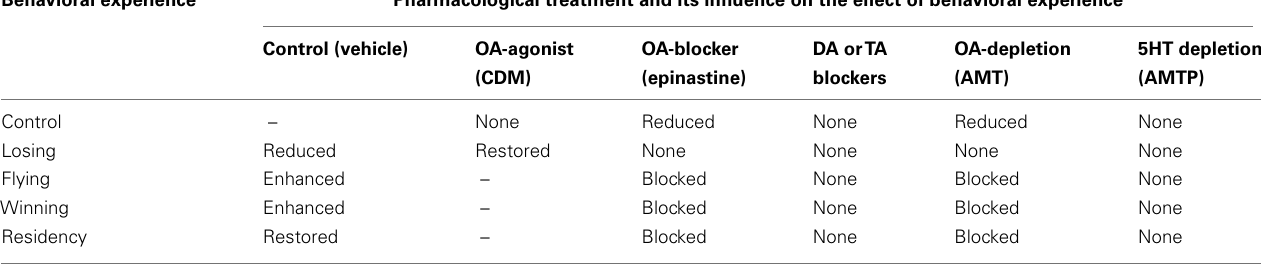
Table 1 | Effect of various behavioral experiences on the fighting behavior of adult male crickets (control), and how these effects are influenced by selected pharmacological